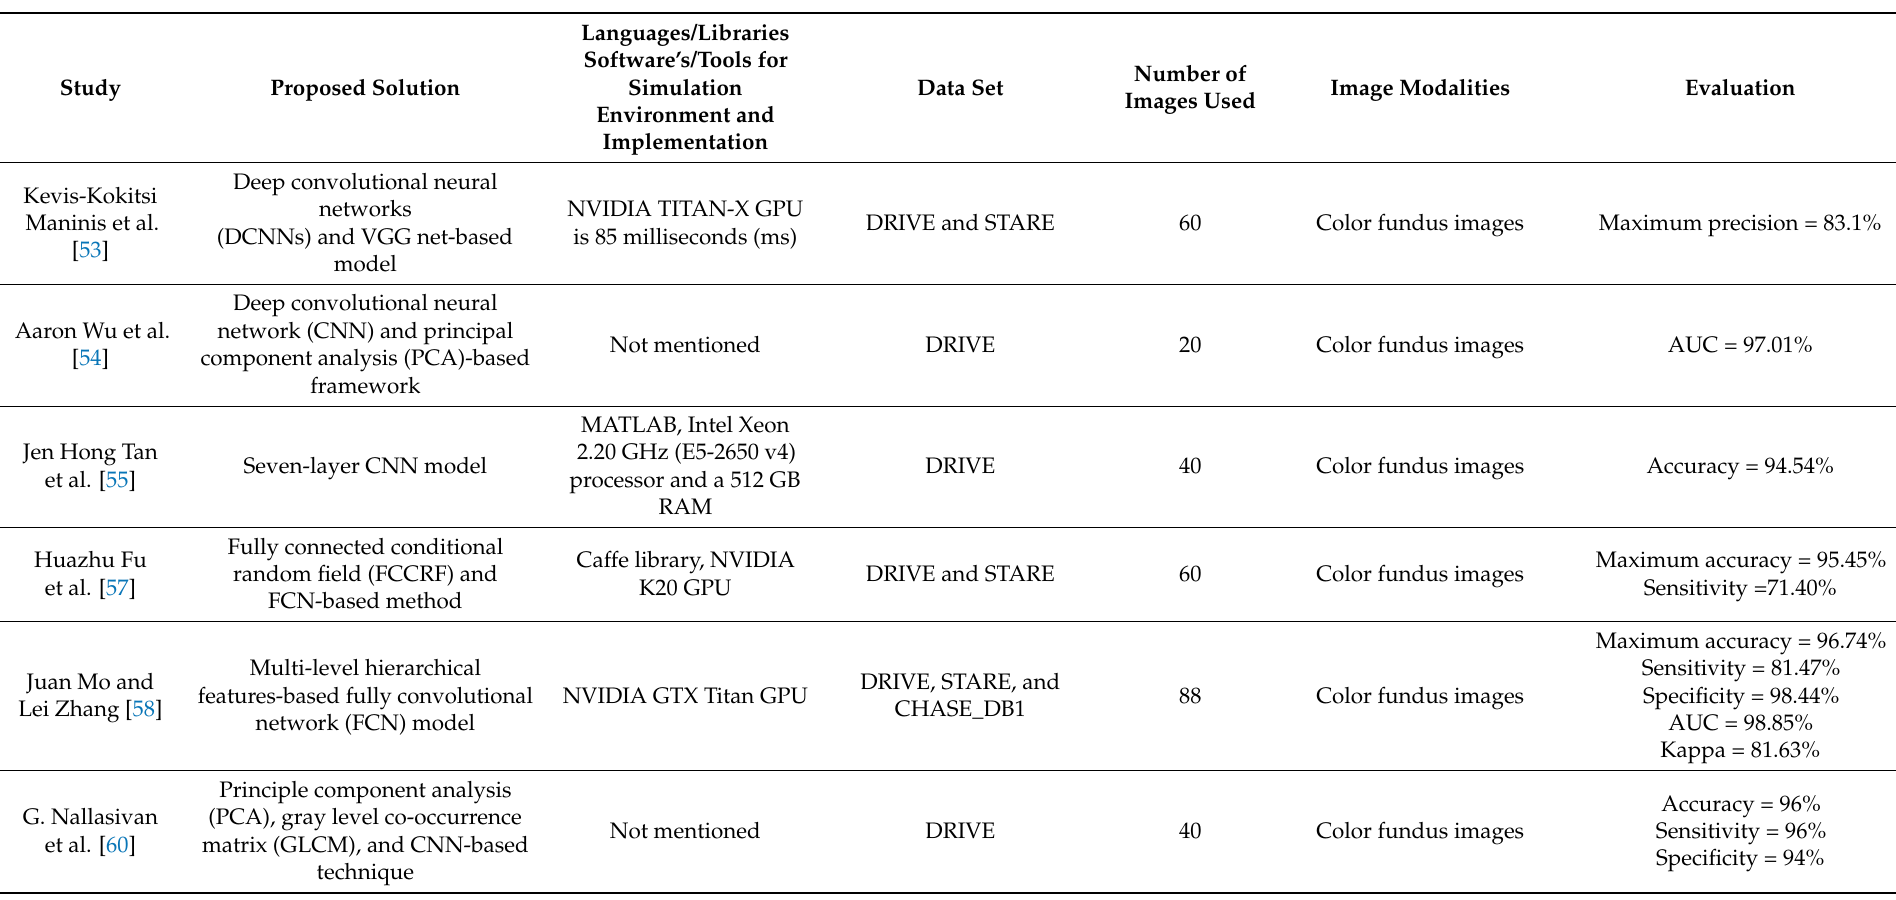
Table 2. A summary of the reported techniques for retinal blood vessel